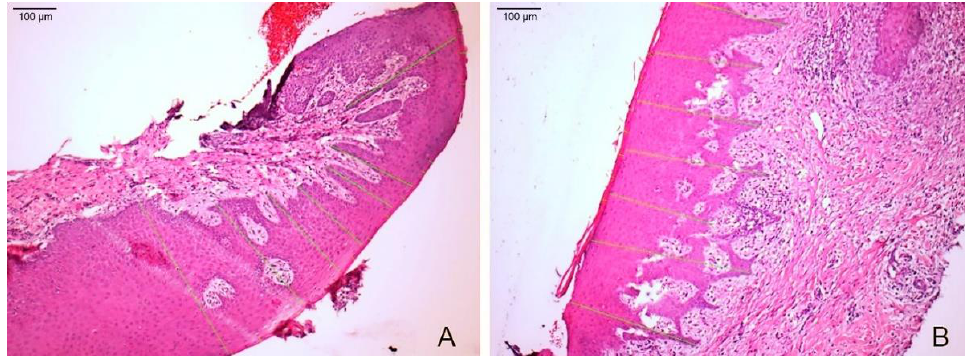
Figure 6. ( A ) Microphotography of the sample treated with an acellular dermal matrix of porcine origin (100×). ( B ) Microphotography of the sample treated with subepithelial autogenous connective tissue (100×). The distance from the keratin layer to the underlying connective tissue is indicated with green lines.